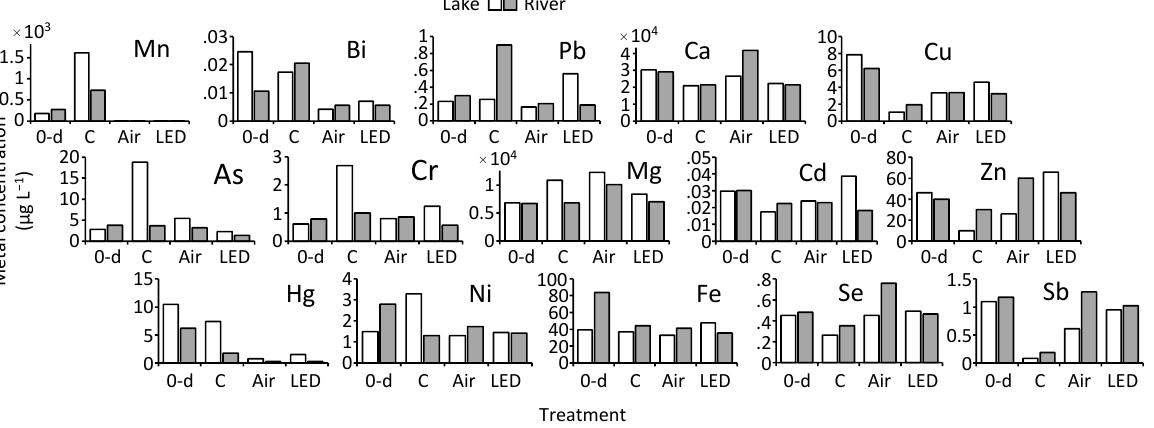
Figure 4. Concentrations of 15 metals in the water of the microcosms with lake or river sediment. Metals were arrayed in the decreasing order of the control to LED ratio from left to right. 0-d: day 0, C: control.